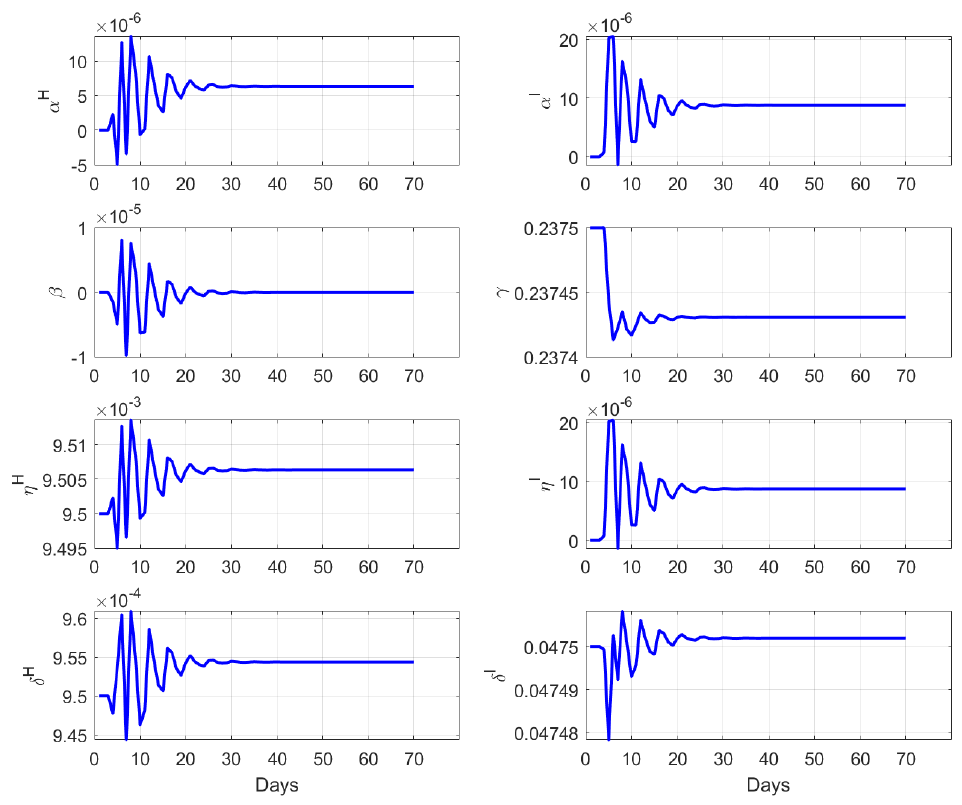
Figure 11. The Extended Kalman Filter (EKF) estimated parameters used for the predictions.